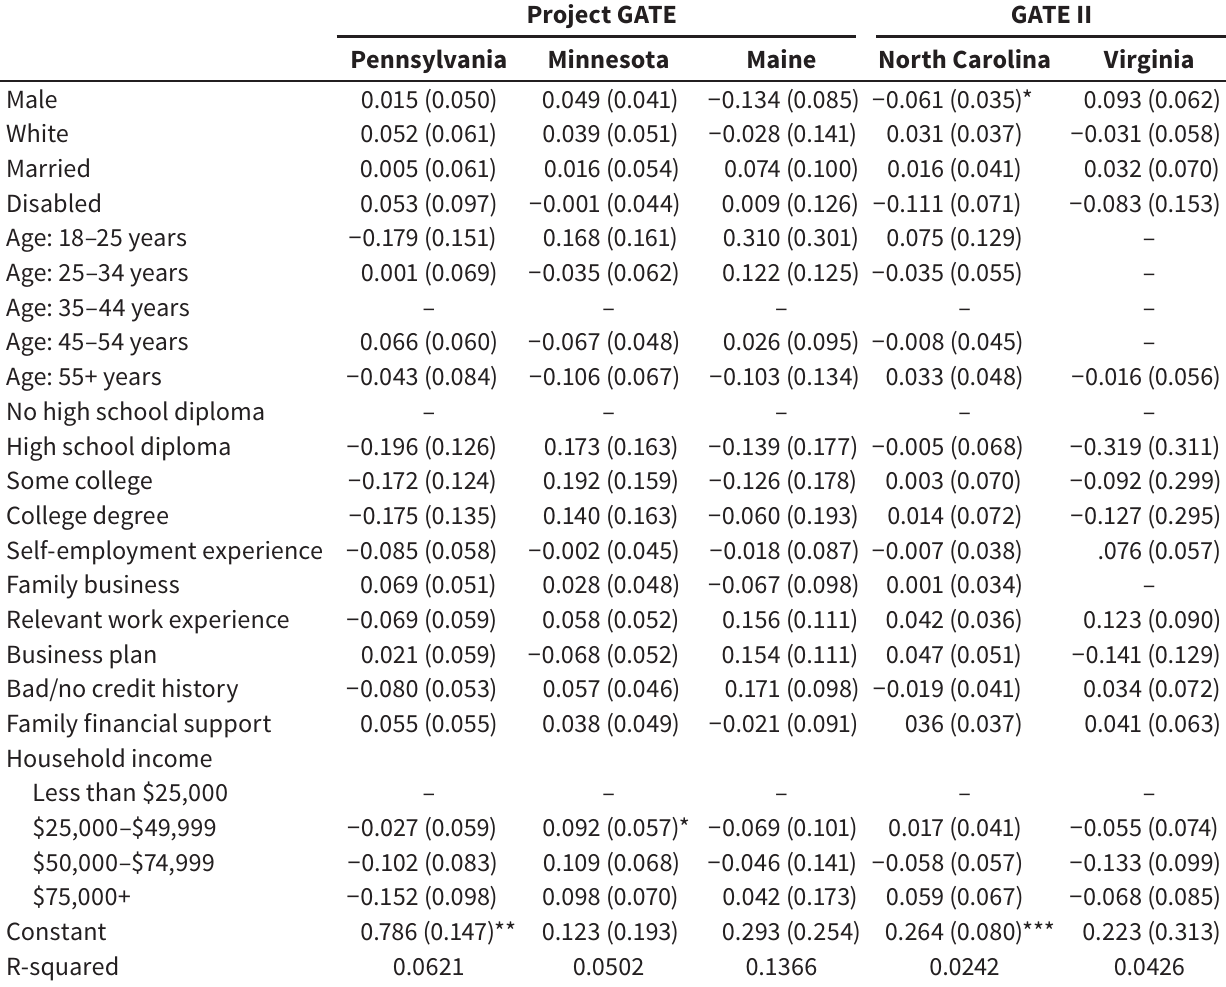
Regression results, treatment likelihood, survey respondents